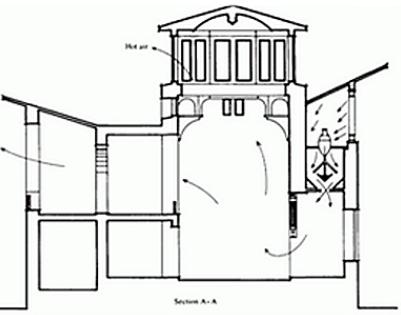
fig. 6. Inducing stack effect through well designed courtyards and properly placed openings at different levels by Hasan fathy